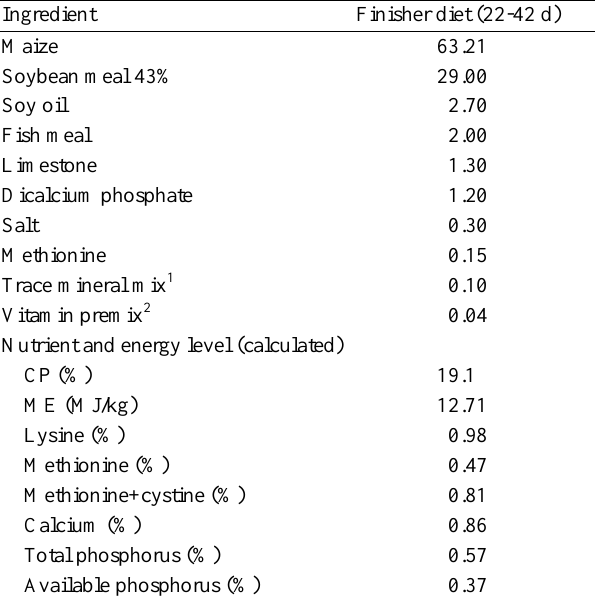
Table 1. Basal diet composition and chemical analysis